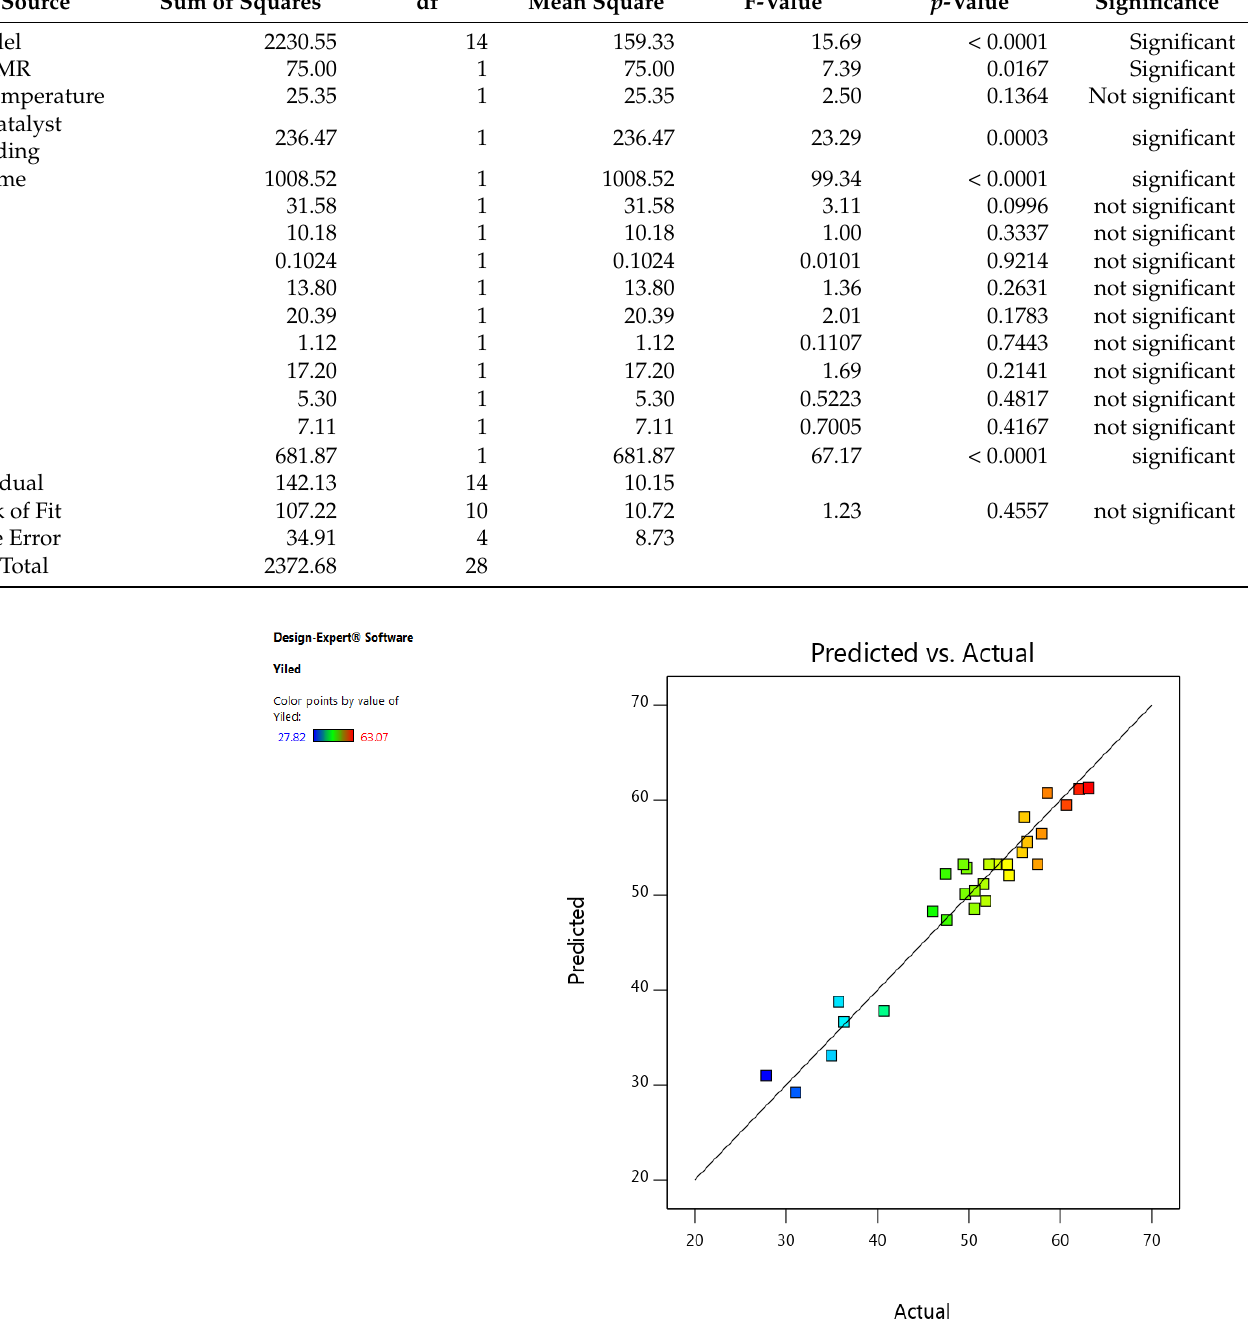
Figure 3. Residual versus predicted response.